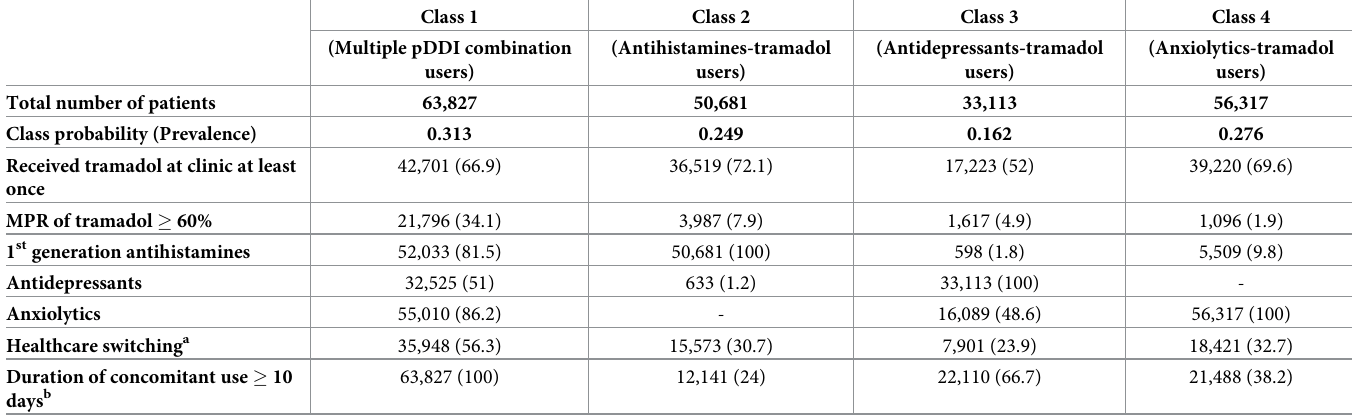
Table 1. Characteristics of the four latent classes of tramadol users with potential drug-drug